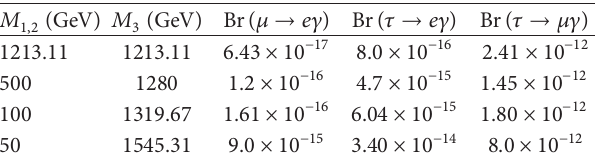
Table 2: Branching ratios for LFV decays 𝜇 → 𝑒𝛾 , 𝜏 → 𝑒𝛾 , and 𝜏 → 𝜇𝛾 as function of 𝑀 (𝑖 = 1, 2,3) 푖